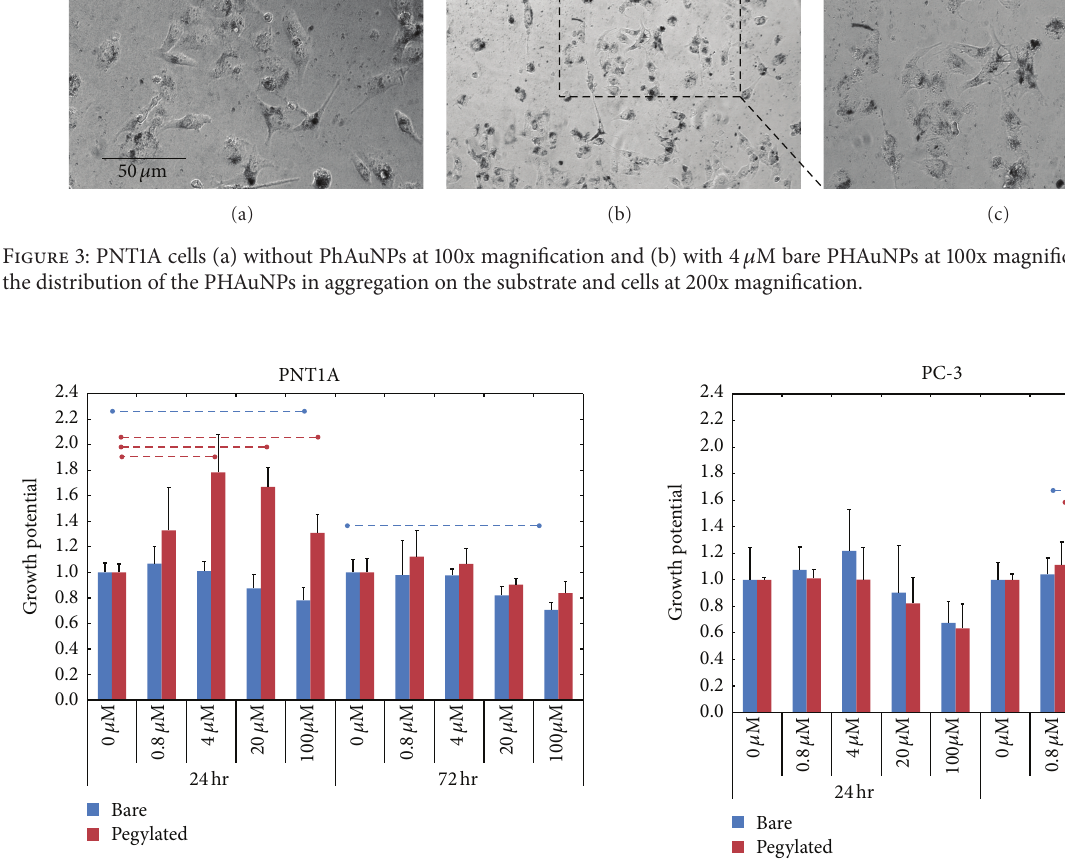
Figure 5: Proliferation of PC-3 after treatment with bare and pegylated PHAuNPs indicating inhibitory effect at 100 𝜇 M after 72 hours in both